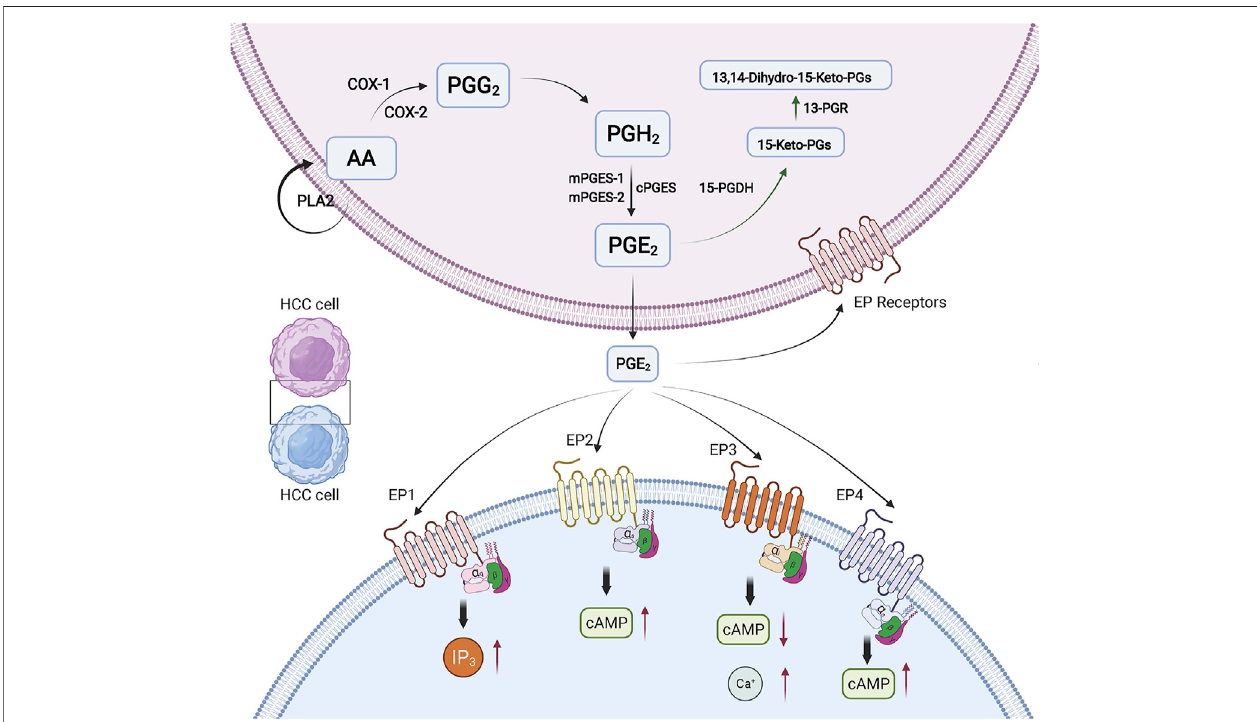
FIGURE 1 | PGE2 in HCC. The biosynthesis and function of PGE2 in HCC is shown. The red arrows indicate the changed expression of molecules. The green arrows indicate the degradation pathway of PGE2. Created with BioRender.com. 15-PGDH, 15-hydroxyprostaglandin dehydrogenase; 13-PGR, 15-keto-